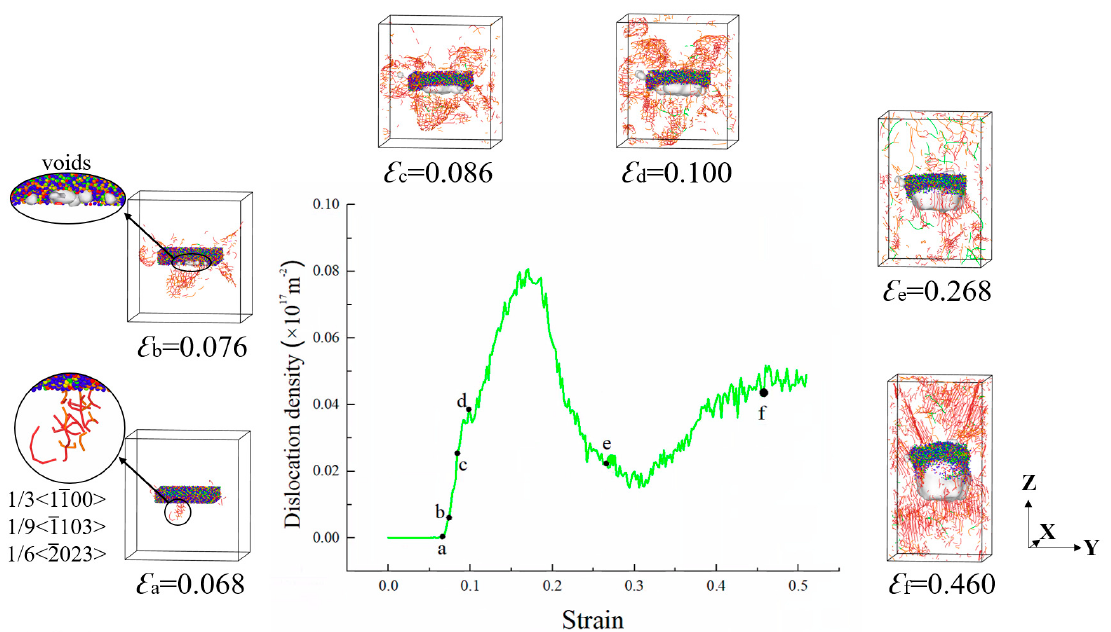
Figure 4. Dislocation density variation and free surface evolution with strain of a single-crystal system with a precipitate during tensile process (the internal white clouds represent voids).